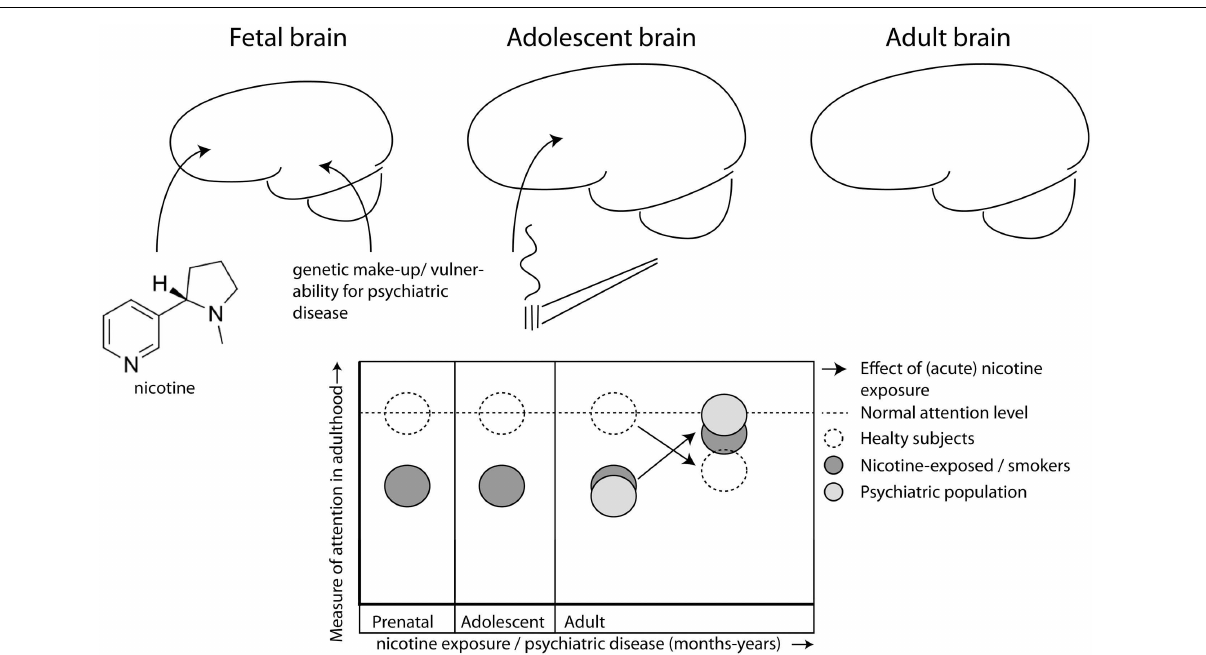
FIGURE 1 | Nicotine exposure during prenatal and/or adolescent development has long-lasting detrimental effects on attention, even after prolonged abstinence. Exposure during both developmental periods (dark gray) has additive effects leading to worse performance than healthy controls (open, hatched line) during adulthood. Patients with certain psychiatric disorders (e.g., ADHD, schizophrenia; light gray) also suffer from